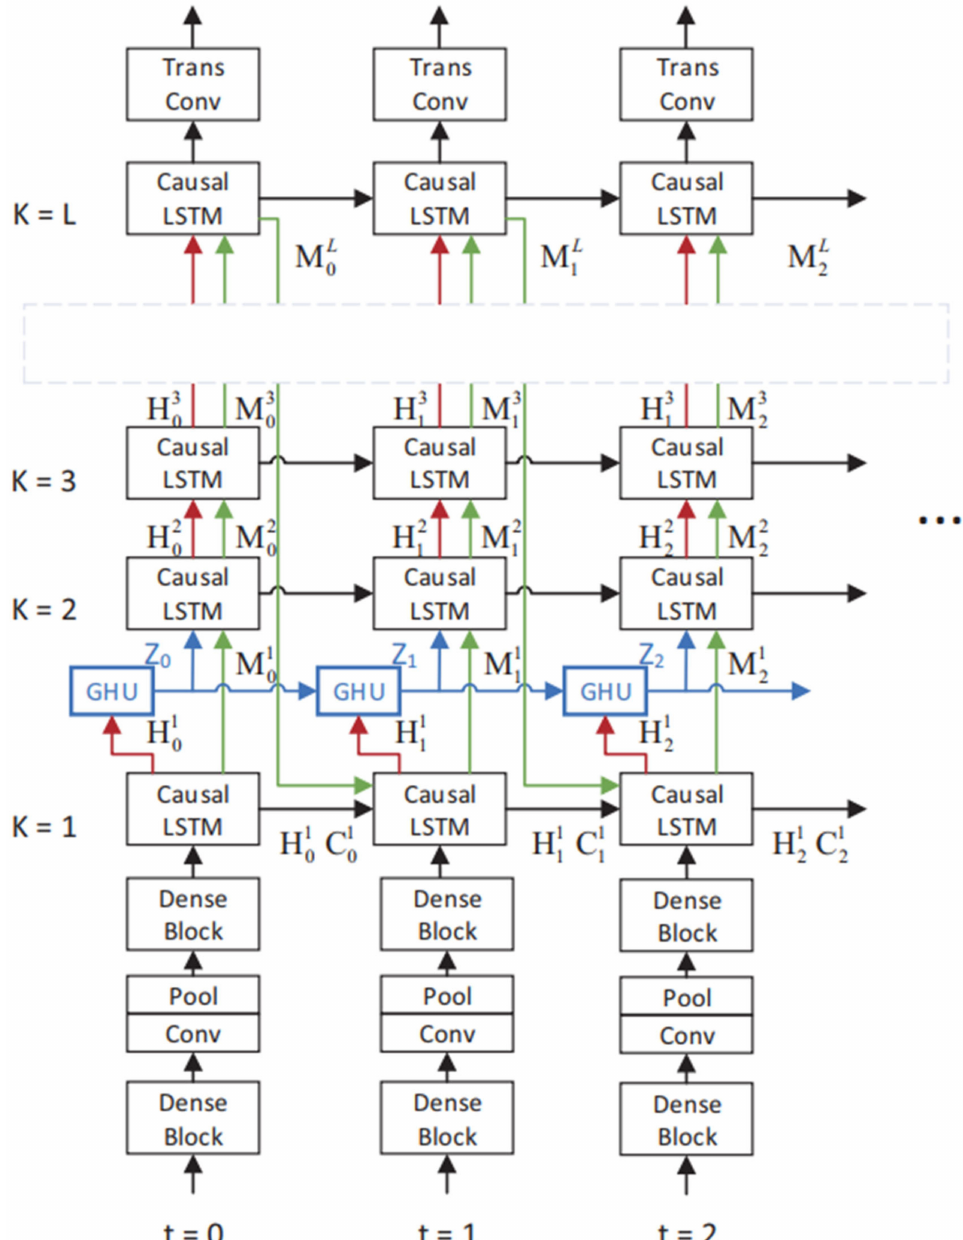
Figure 8. Model structure diagram of DC-LSTM